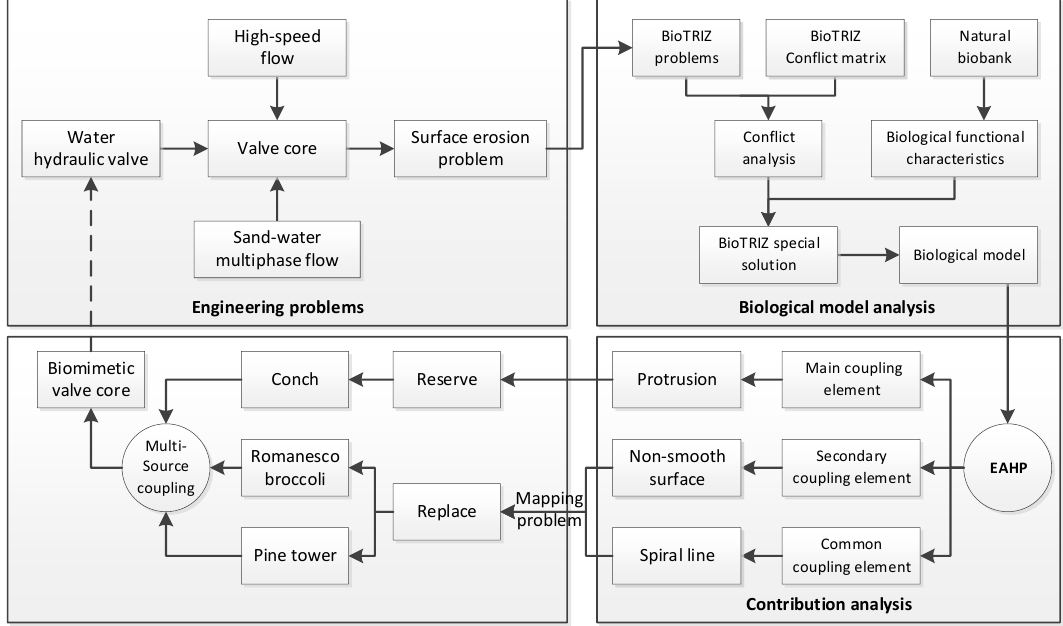
Figure 1. Framework of the multi-source coupling